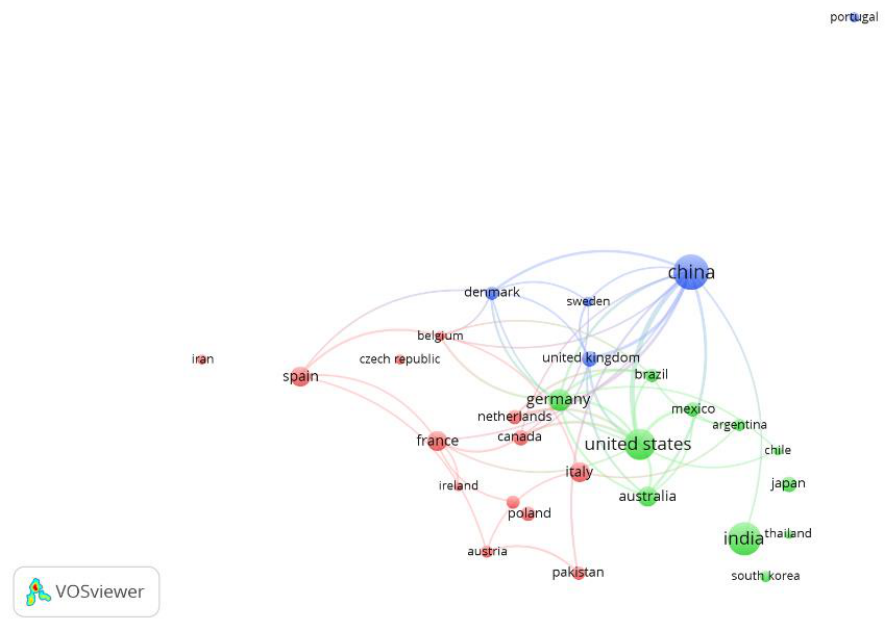
Figure 3. Collaborative clustering map of the countries based on the affiliations of co-authorships in Scopus soil microbial inoculants publications. The three different colors represent different collaboration clusters. The size of the country is based on the number of publications. The connecting lines indicate the 50 strongest co-occurrence links between countries.